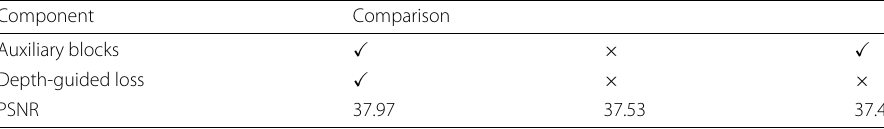
Table 3 Ablation studies for the network